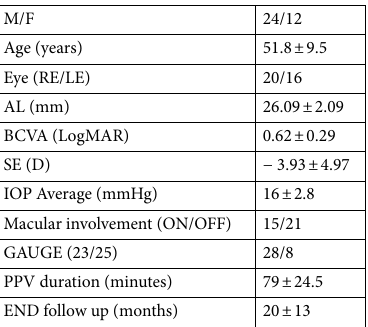
Table 1. Patients’ demographics and ocular findings at baseline. M males, F females, AL axial length, BCVA best corrected visual acuity, SE spherical equivalent, IOP intraocular pressure, PPV pars plana